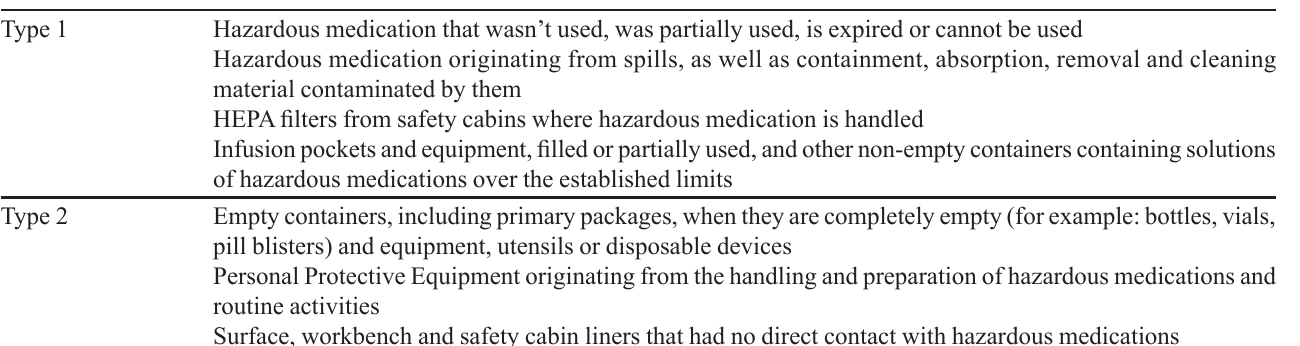
TABLE IV - Classification of the types hazardous medication waste Type